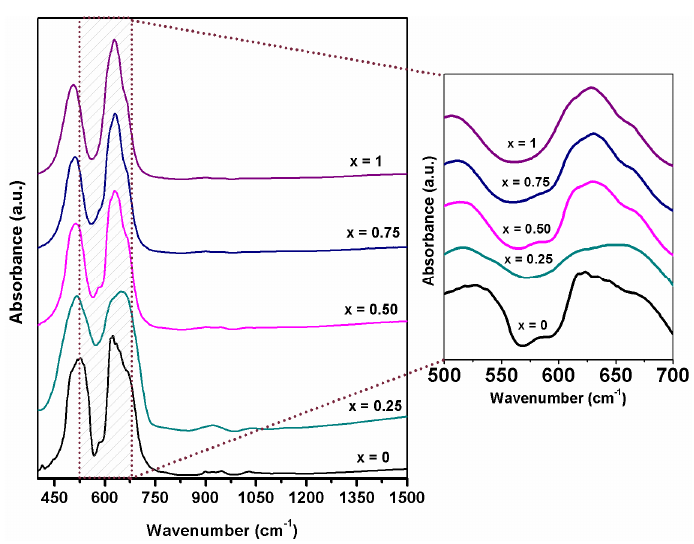
Figure 5. FT-IR spectra of Co (1 − x) Ni x Cr 2 O 4 (x = 0, 0.25, 0.5, 0.75 and 1).